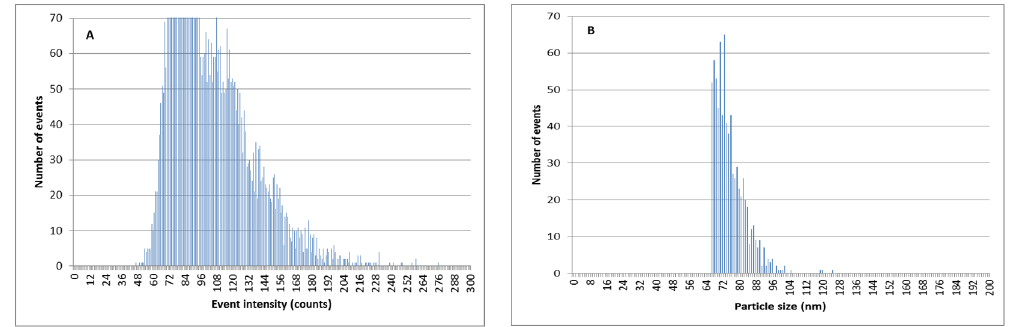
Figure 8. SP-ICPMS histograms of a mixture of Ag + and PVP-AgNPs of 75 nm 5:1. ( A ) Signal distribution. ( B ) Particle size distribution.